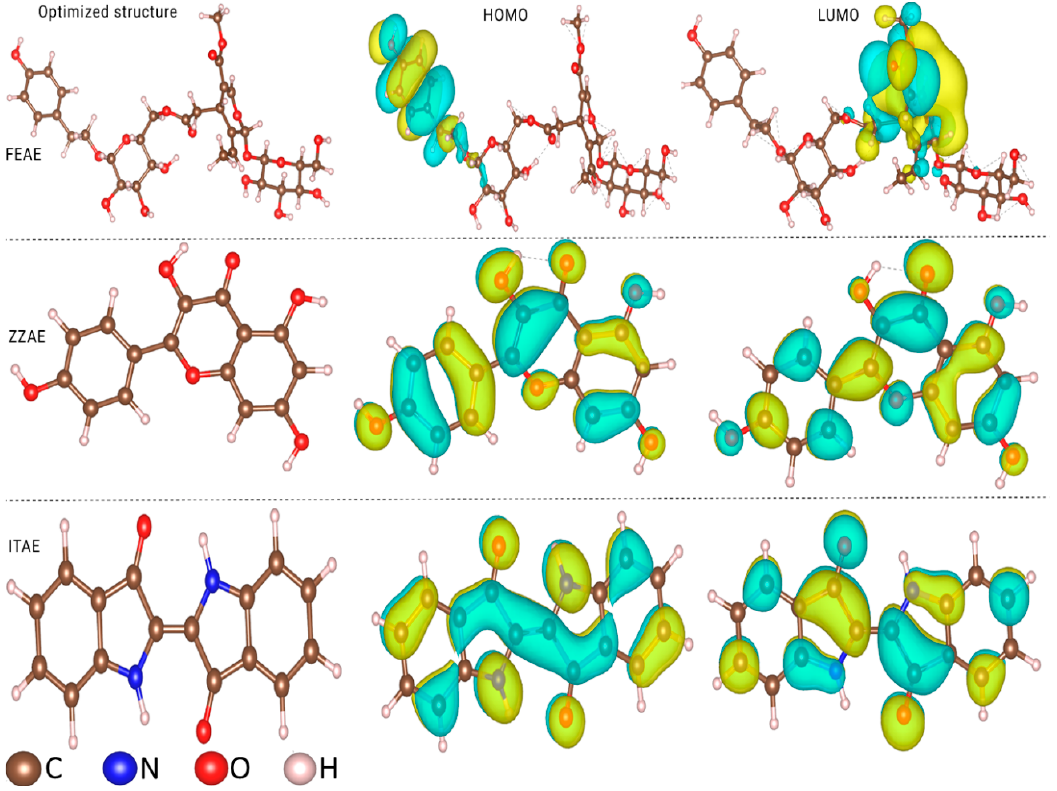
Figure 7. Optimized geometries and MO distributions of the major components in natural plant extracts.